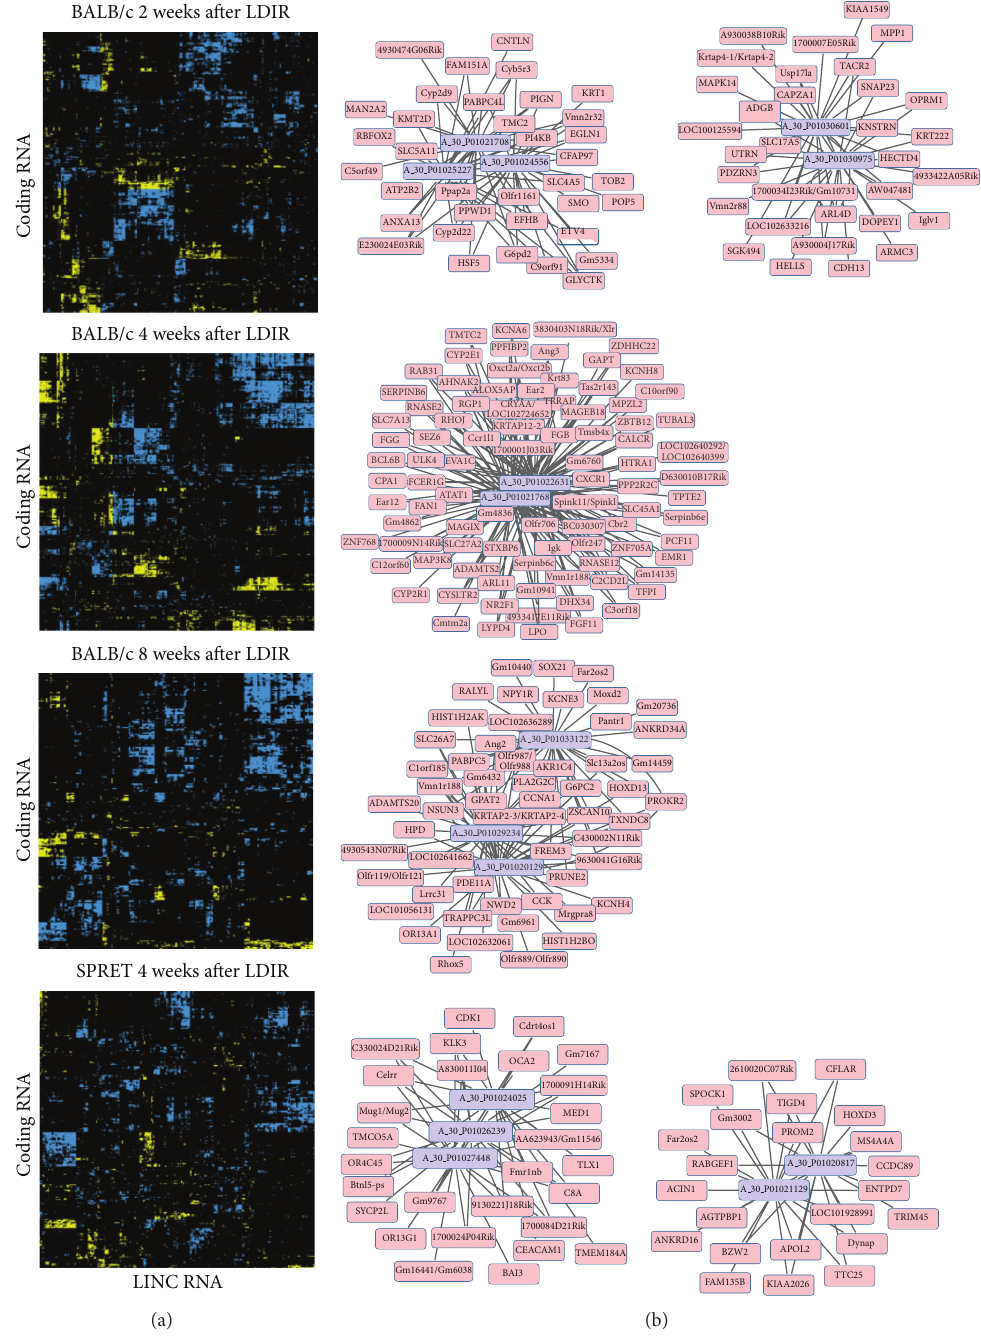
Figure 4: Correlated lncRNA and coding RNA expression in mammary tissues after low-dose radiation exposure. (a) Correlation graphs of the average expression values from each experimental treatment group for each mRNA and lncRNA differentially expressed after LDIR at each of the four timepoints. Positive and negative correlations are indicated in blue and yellow, respectively. (b) Representative examples of networks of lncRNAs (purple) significantly correlated in expression with mRNAs